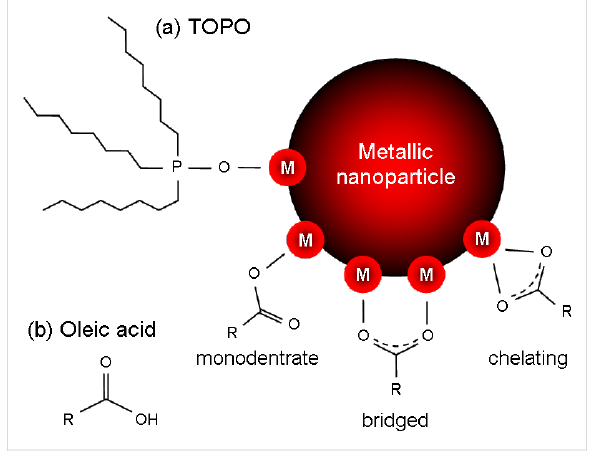
Figure 2: Interaction of different ligands with the surface of a metallic nanoparticle. There is only a single binding motif for TOPO (a) but three for ligands such as oleic acid